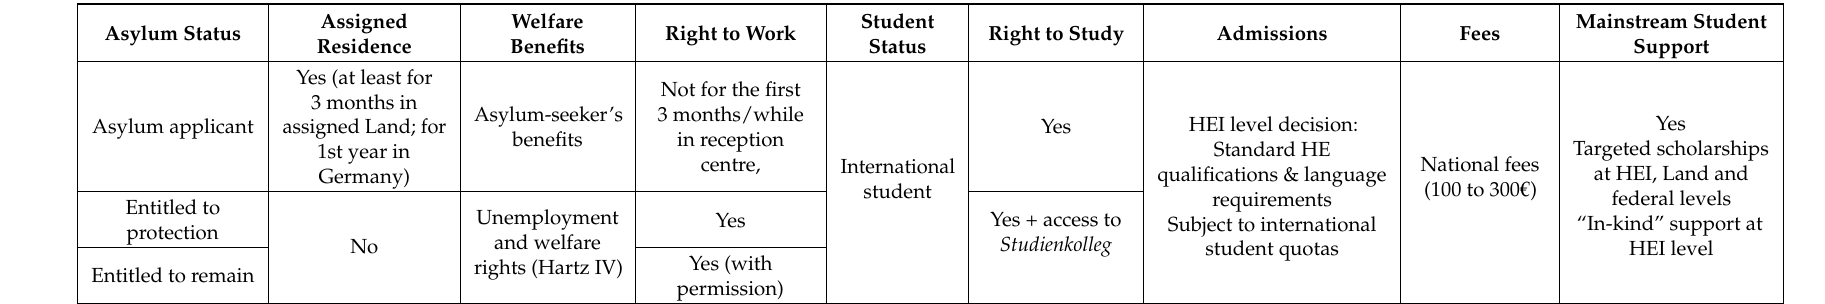
Table 2. Administrative refugee status and corresponding welfare and student rights in